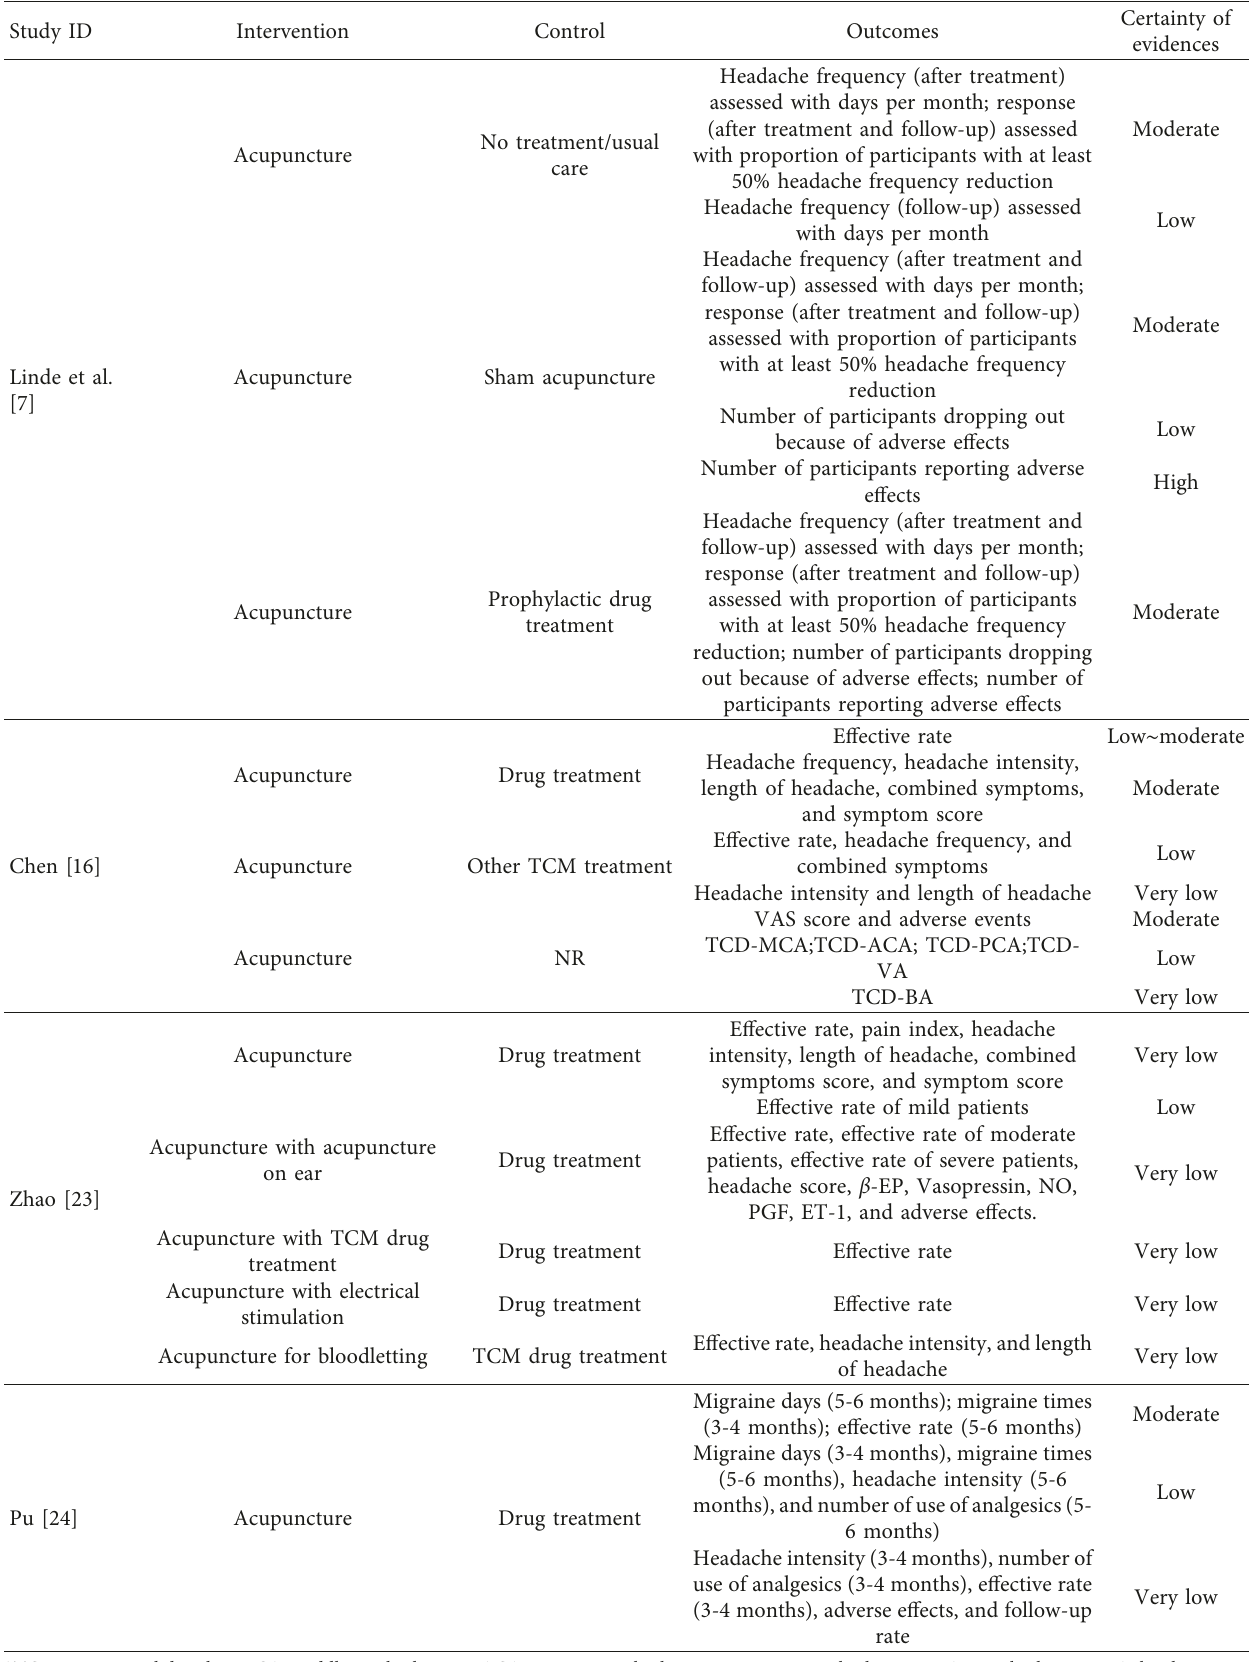
Table 2: Certainty of evidences reviewed by GRADE